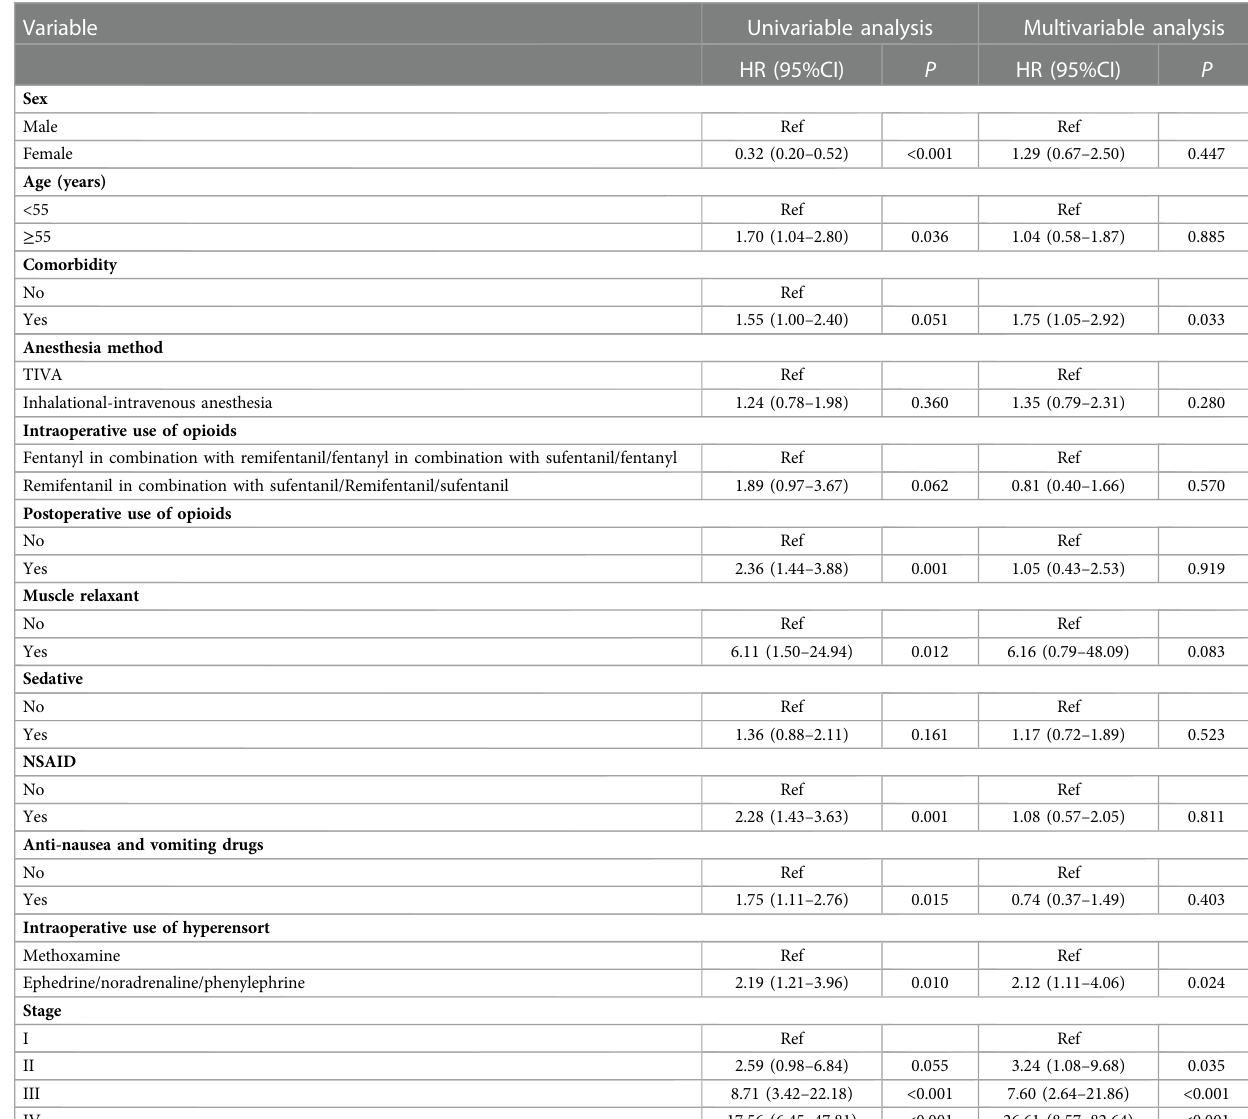
TABLE 3 Prognostic analysis of the survival of